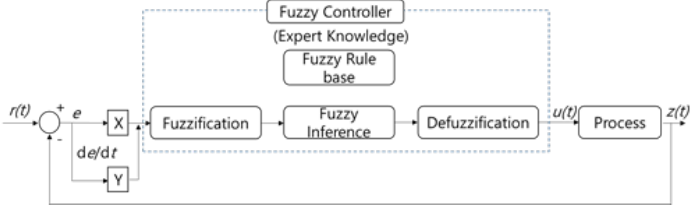
Figure 2. Structure of a general fuzzy controller.